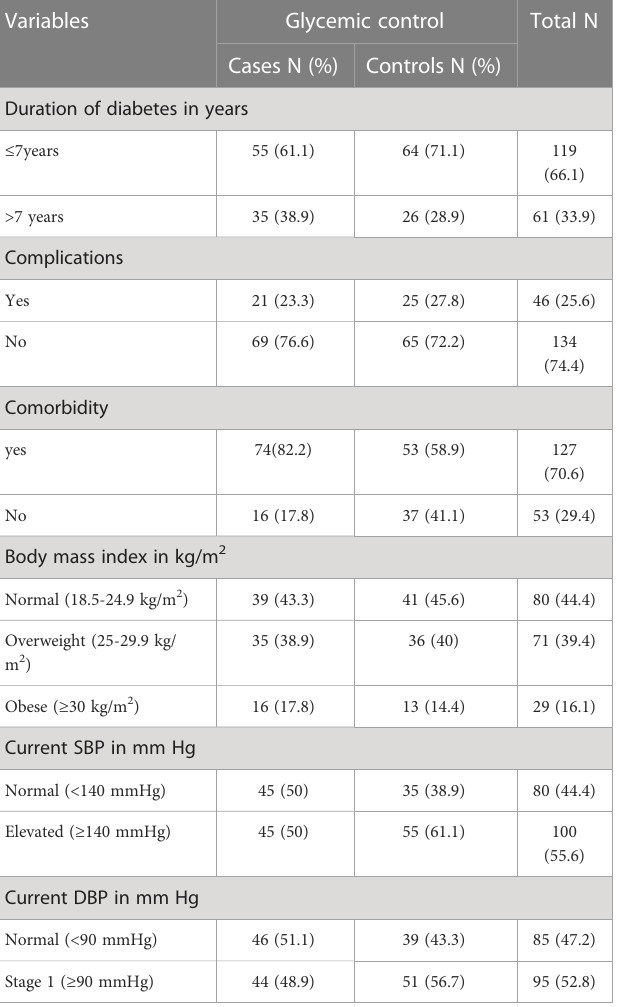
TABLE 3 Clinical characteristics of type 2 diabetes mellitus patients at DM clinic of UoGCSH, Northwest Ethiopia, 2020 (N=180). Variables Glycemic control